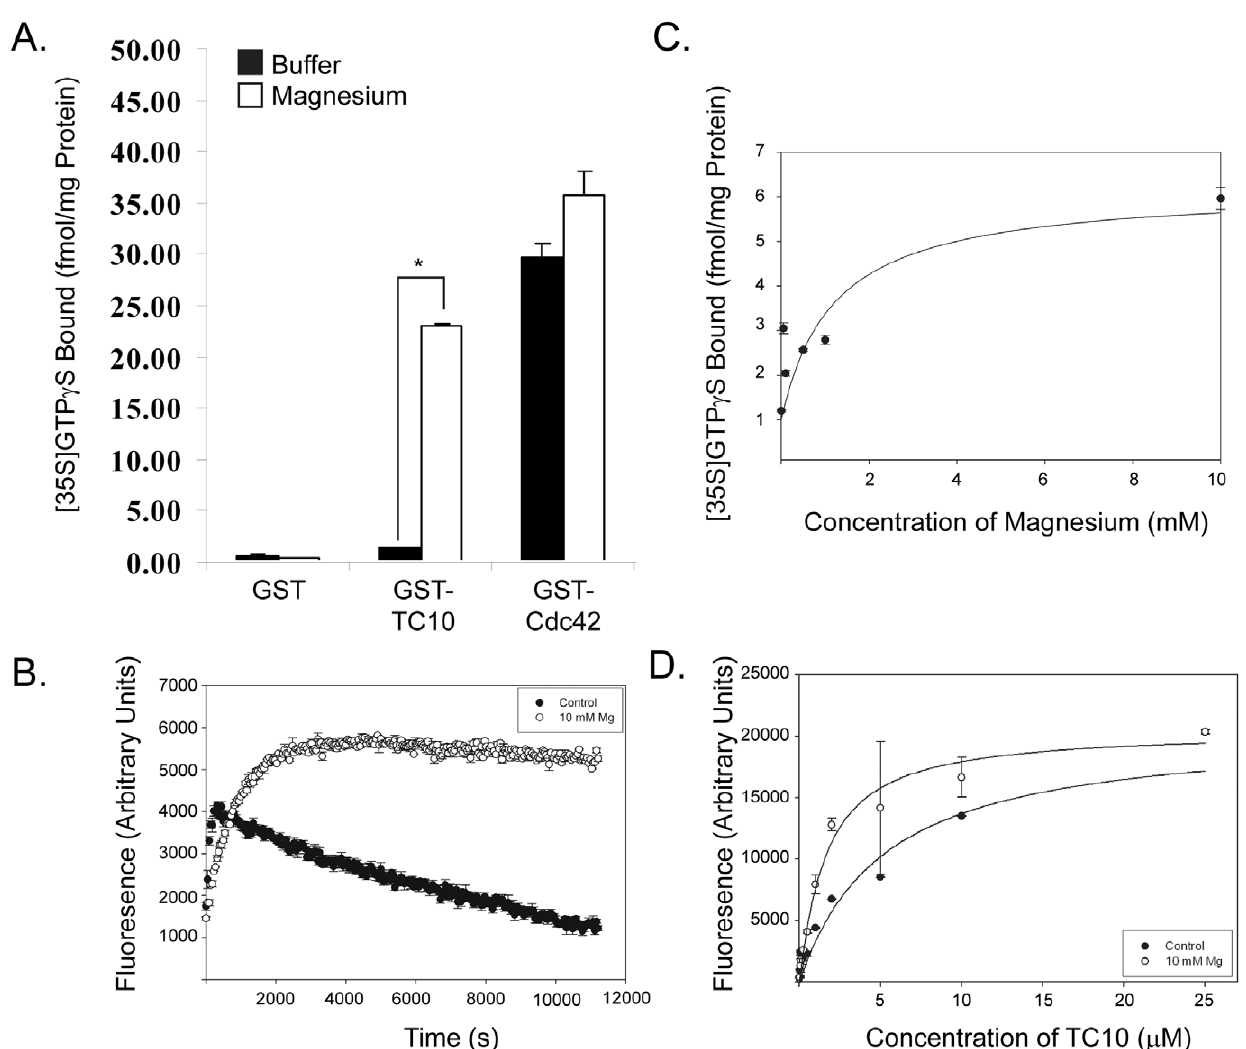
Figure 1. TC10 requires magnesium for stable nucleotide binding. A) Binding of [ 35 S]-GTP c S to GST, GST-TC10 and GST-Cdc42 in the absence (black bars) or presence (white bars) of 10 mM MgCl 2 . B) Time-course of mantGDP binding to TC10 in the absence (control) and presence of 10 mM MgCl 2 . C) GST-TC10 was combined with [ 35 S]-GTP c S in the presence of varying concentrations of supplemental magnesium. D) Titration of 50 nM mGDP with varying concentrations of GST-TC10 in the absence (control) or presence of 10 mM MgCl 2 . Samples were incubated 2 h at room temperature before fluorescence measurement. Curve fitting and K D calculations were determined according to (20). Data is presented as mean with standard error bars. Asterisks indicate p ,